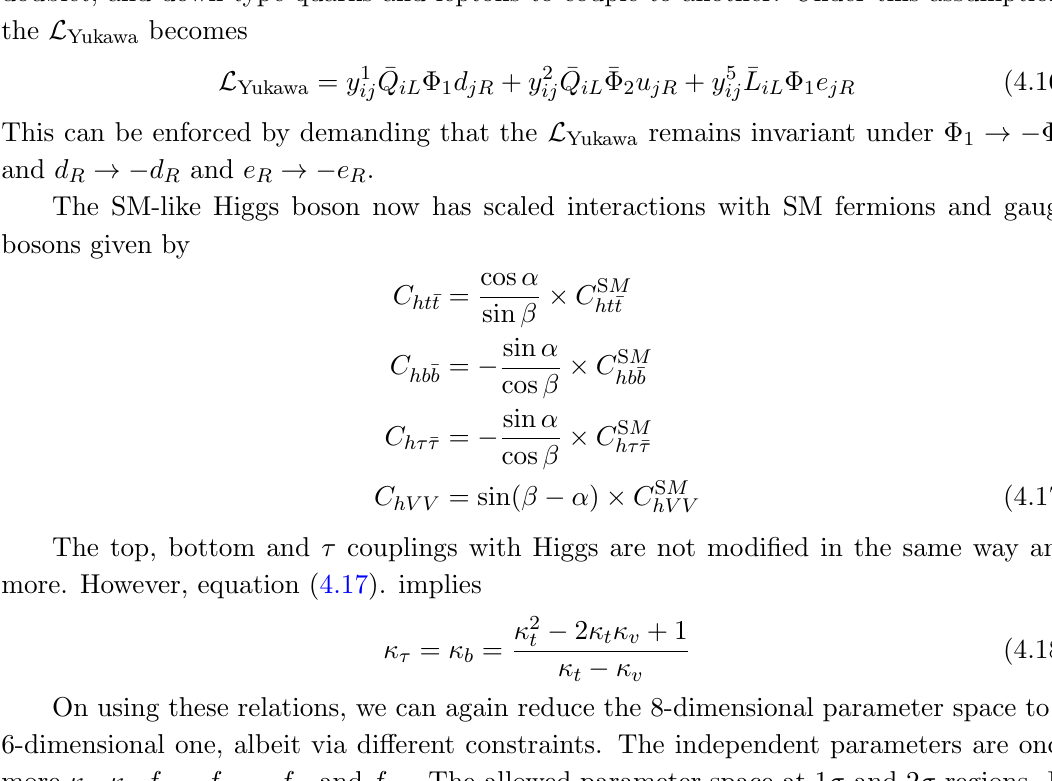
Figure 8 . Allowed regions at 1 (cid:27) (red) and 2 (cid:27) (blue) levels in the parameter space of f ( m g (left) and sin( (cid:12) (cid:0) (cid:11) ) (cid:0) f ( m hH + H (cid:0)